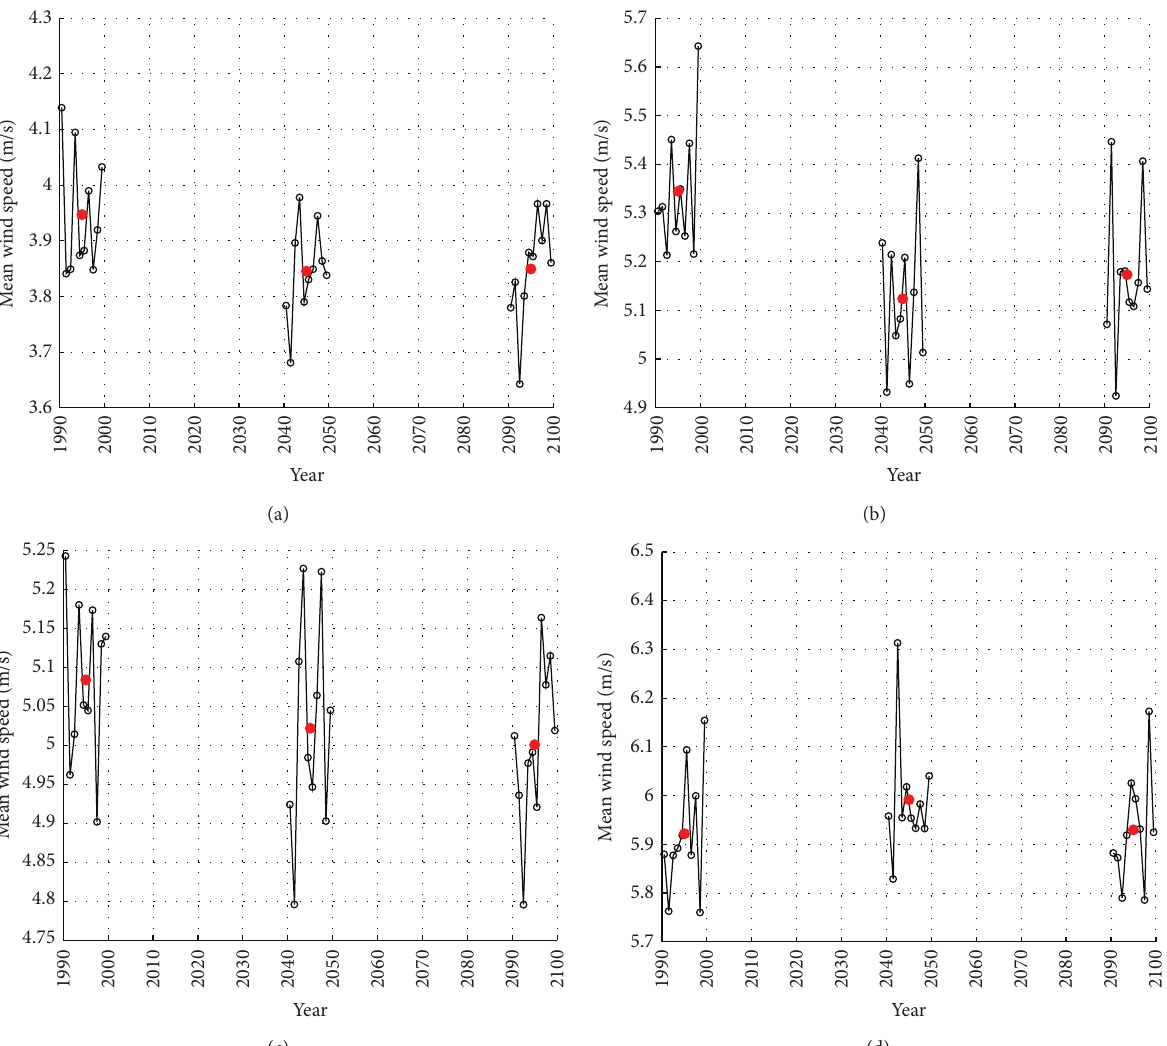
Figure 9: Mean wind speed (ms −1 ) time series for the (a) southeastern US, (b) Rocky Mountains, (c) North Carolina, and (d) Great Plains regions. The average annual wind speed is plotted for current climate (1990–1999) and future climate decades 2040s and 2090s. The black and white points represent yearly mean wind speeds and the red points represent the overall 10-year averages for each